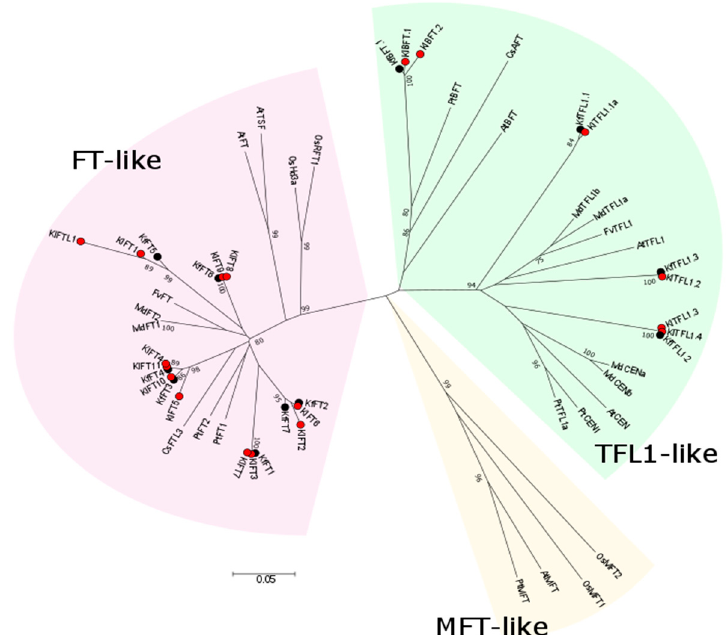
Figure 1. Phylogenetic analysis of proteins from the PEBP family. Full-length amino acid sequences of PEBP family proteins from Kalanchoë. Arabidopsis thaliana —At (BAA77838.1, NP_196004.1, NP_201010.1. NP_173250.1, NP_193770.1, NP_180324.1); Oryza sativa —Os (BAO02979.1, BAO03159.1, Q656A5, Q9ASJ1);